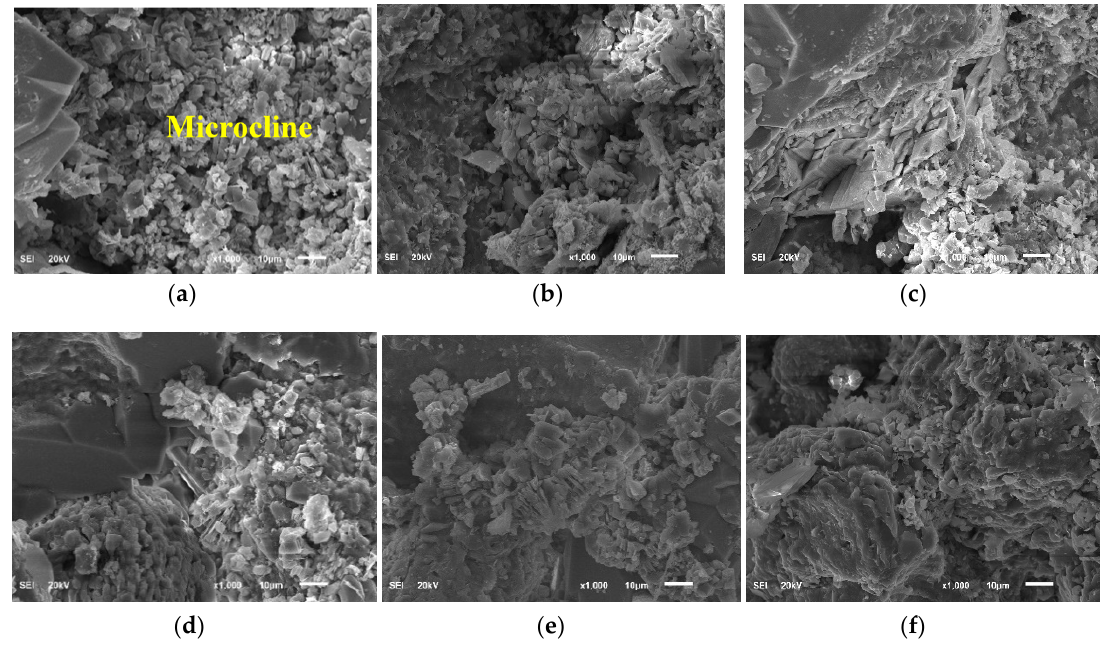
Figure 7. SEM results: ( a ) Dry sample; ( b ) saturated sample; ( c ) after 30 min of interaction; ( d ) after 1 day of interaction; ( e ) after 3 days of interaction; and ( f ) after 5 days of interaction.